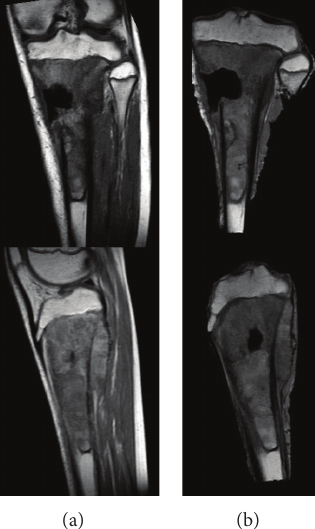
Figure 2: 14-year-old patient (n. 7) with osteosarcoma of the distal femur with multiple bone metastases. The tumour was very voluminous and painful and the patient was not able to walk. The goal of the surgery was to allow the child to walk but was not curative. The resection margins were classified R2 by the pathologist and all the observers. On the left: preoperative MRI. On the right: postoperative MRI of the resected